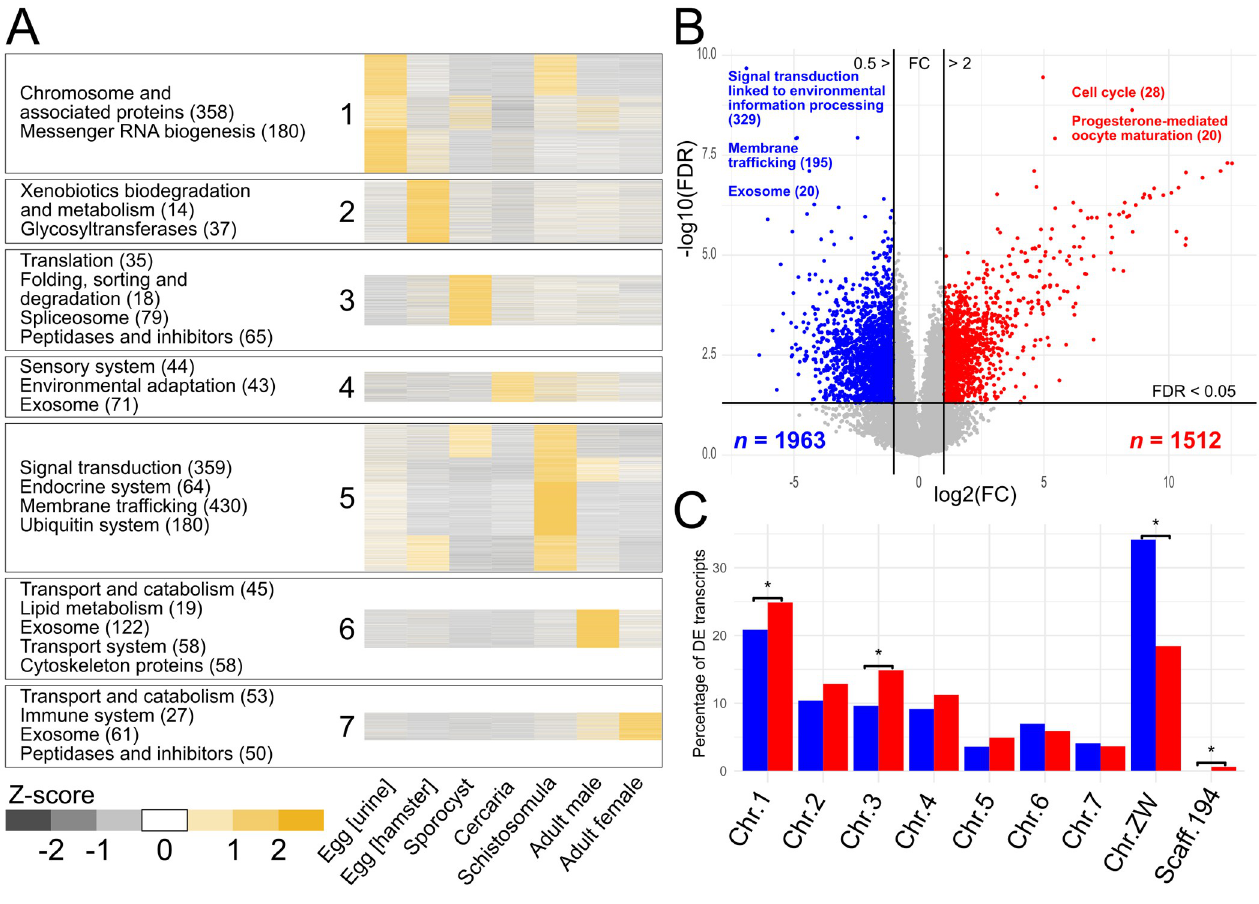
Fig 3. Analysis of transcription for key developmental stages of Schistosoma haematobium . A Transcription profiles of transcript isoforms across seven developmental stages/sexes, clustered (Ward; k = 7) by similarity of Z-score-normalised TPM (transcripts per million) values. Key, enriched (q < 0.05) pathways and/or protein functions are shown to the left of each cluster. Numbers of molecules in round parentheses. B Pairwise comparison of differential (DE; fold change (FC) > 2, false discovery rate (FDR) < 0.05) transcription between male (blue) and female (red) samples, displayed as a ‘volcano’ plot. Key pathways and/or protein functions enriched in DE subsets are highlighted. c Percentage of DE transcripts encoded on each chromosome/scaffold for males (blue) and females (red), respectively; chromosomes/scaffolds enriched (q < 0.05) for male or female DE genes are marked with an asterisk.